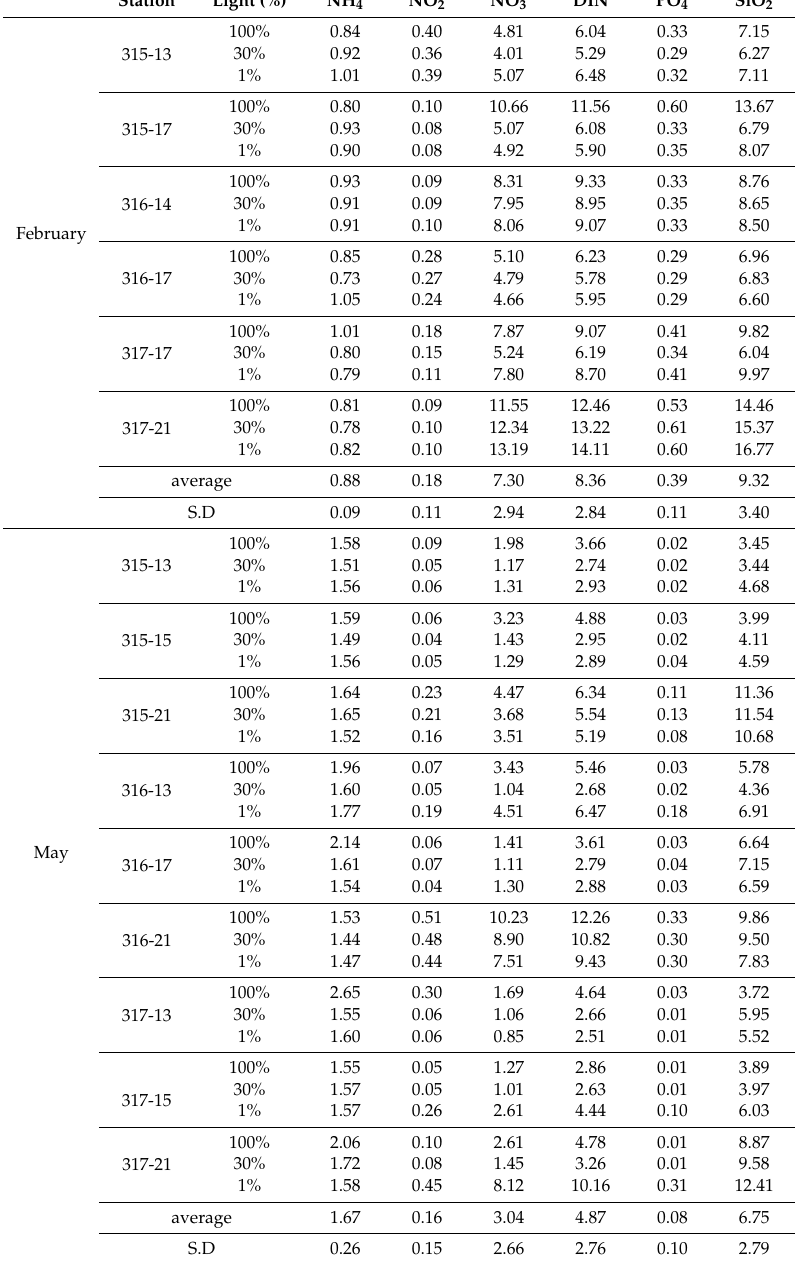
Table 2. The dissolved inorganic nutrient concentrations ( µ M) at the euphotic depths (100%, 30%, and 1%) of water column in the northern East China Sea,